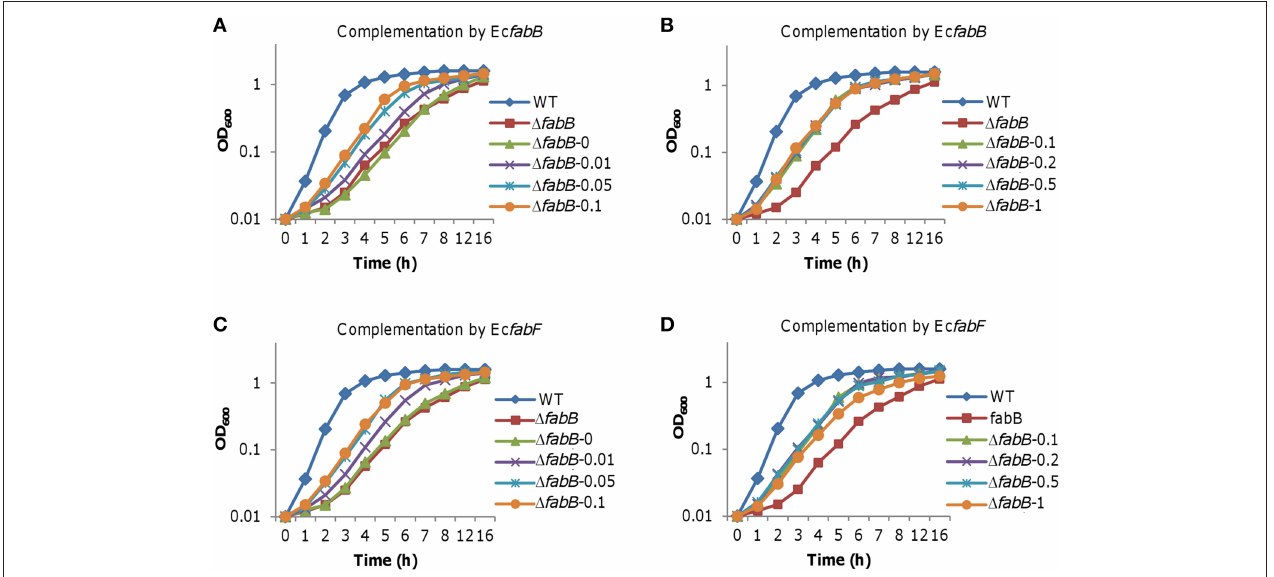
FIGURE 8 | Effect of E. coli FabB and FabF at varying levels on growth of S. oneidensis . Growth of the 1 fabB strain carrying EcfabB and EcfabF driven by P tac in liquid LB was monitored. IPTG at indicated concentrations was used to control production of E. coli FabB and FabF. (A,B) the 1 fabB strain carrying EcfabB . (C,D) the 1 fabB strain carrying EcfabF . In all panels, error bars (less than 10% of the average), representing SD from three independent experiments, were omitted for